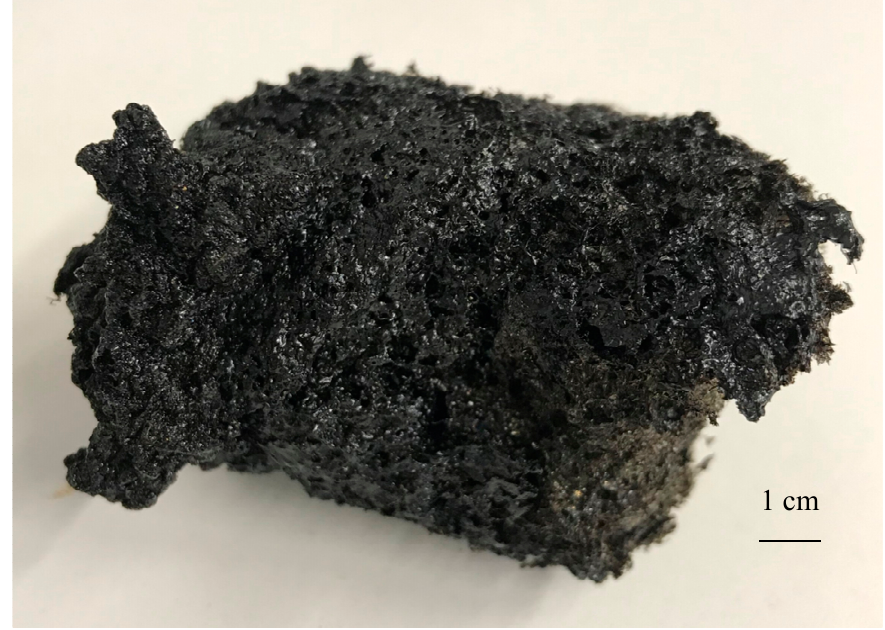
Figure 1. Picture of foamy PFA obtained from Zn-activated polymerization of FA at 80 °C.